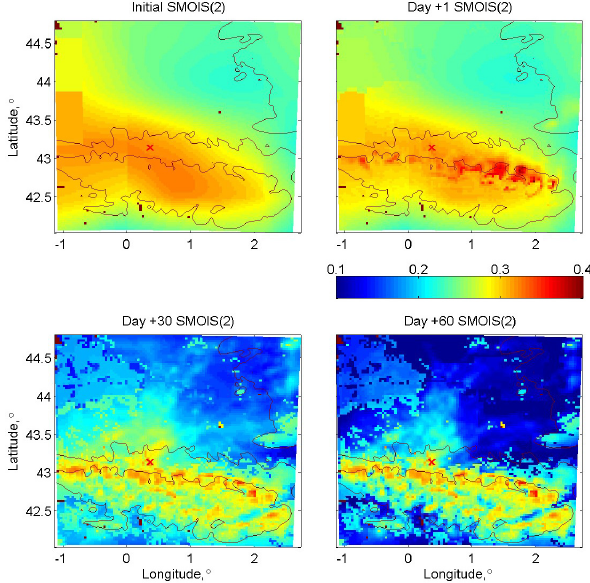
Figure 2. Soil moisture (dimensionless) in the second layer on the inner domain at different times in the cycling experiments. Initial time is 00:00UTC on 1 June 2011. The red X is the Lannemezan measurement site. Elevation contours at 200 and 1000ma.s.l. are